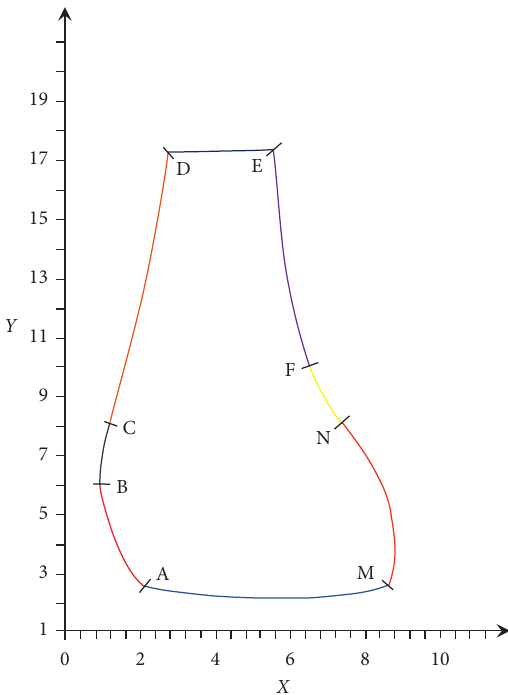
Figure 3: A shape of the transverse-vertical cross section of the orthopedic boot-tree on 0.4 D